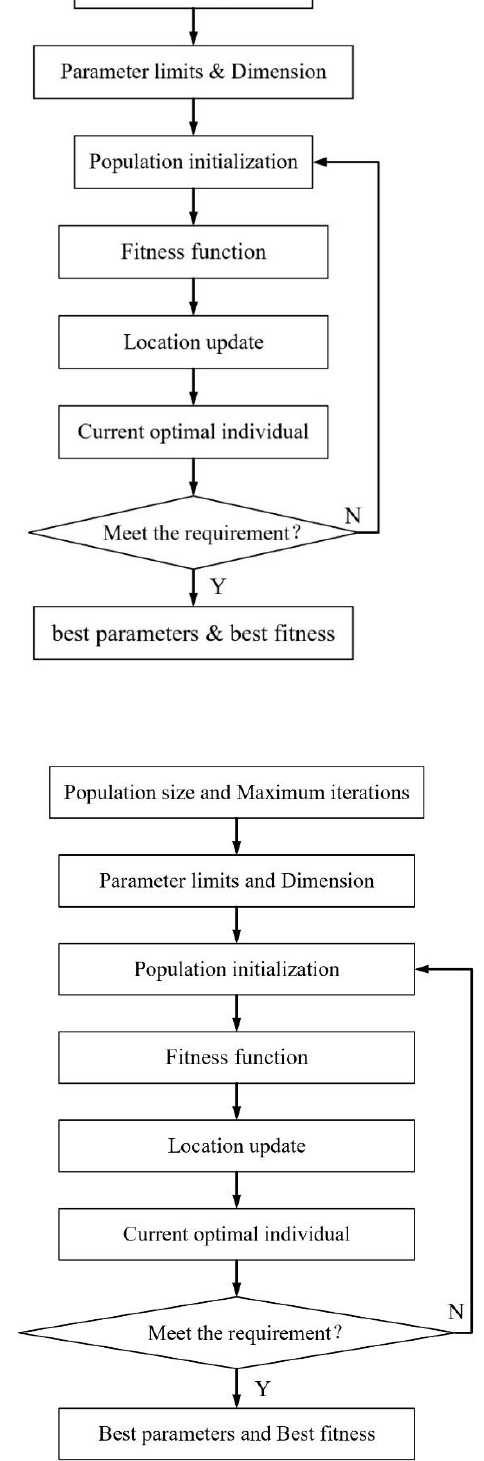
Figure 3. Iterative flow chart of SSA.